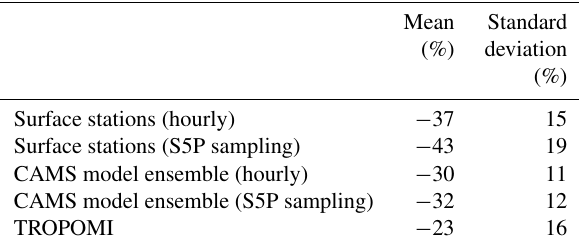
Table 4. Scores over all European urban areas included in the study for the different NO 2 change estimates: based on surface obser- vations, model estimates, and TROPOMI observations. Mean and standard deviation are calculated for all resulting urban-area esti- mates; i.e. the standard deviation is a metric of the inter-urban-area